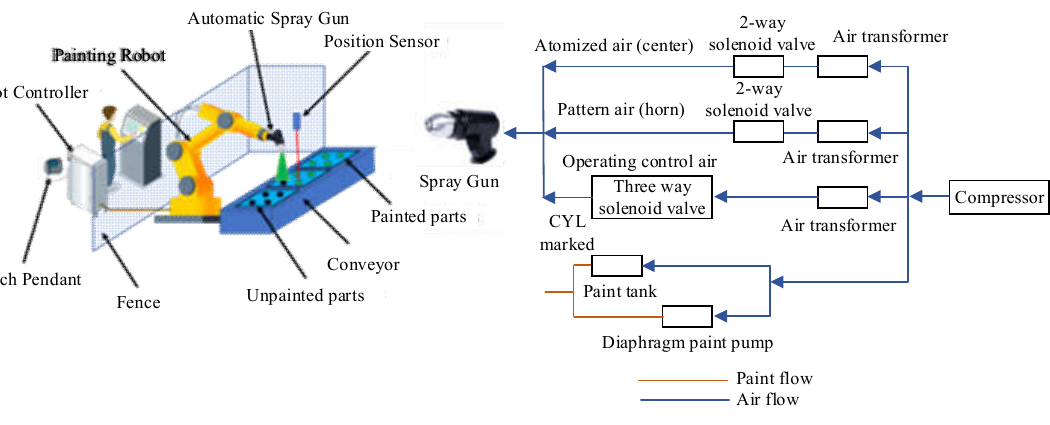
Figure 1. Traditional Painting Robot.